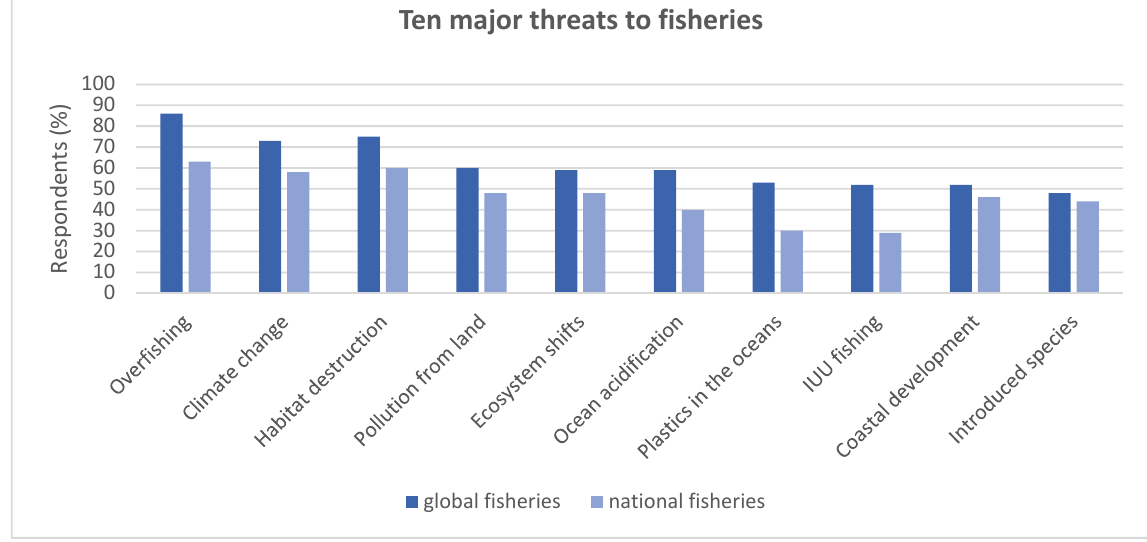
Figure 5. The 10 major threats to national and global fisheries (n = 164).